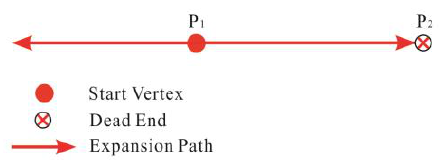
Figure 13. A basic expansion in a dead-end road segment.